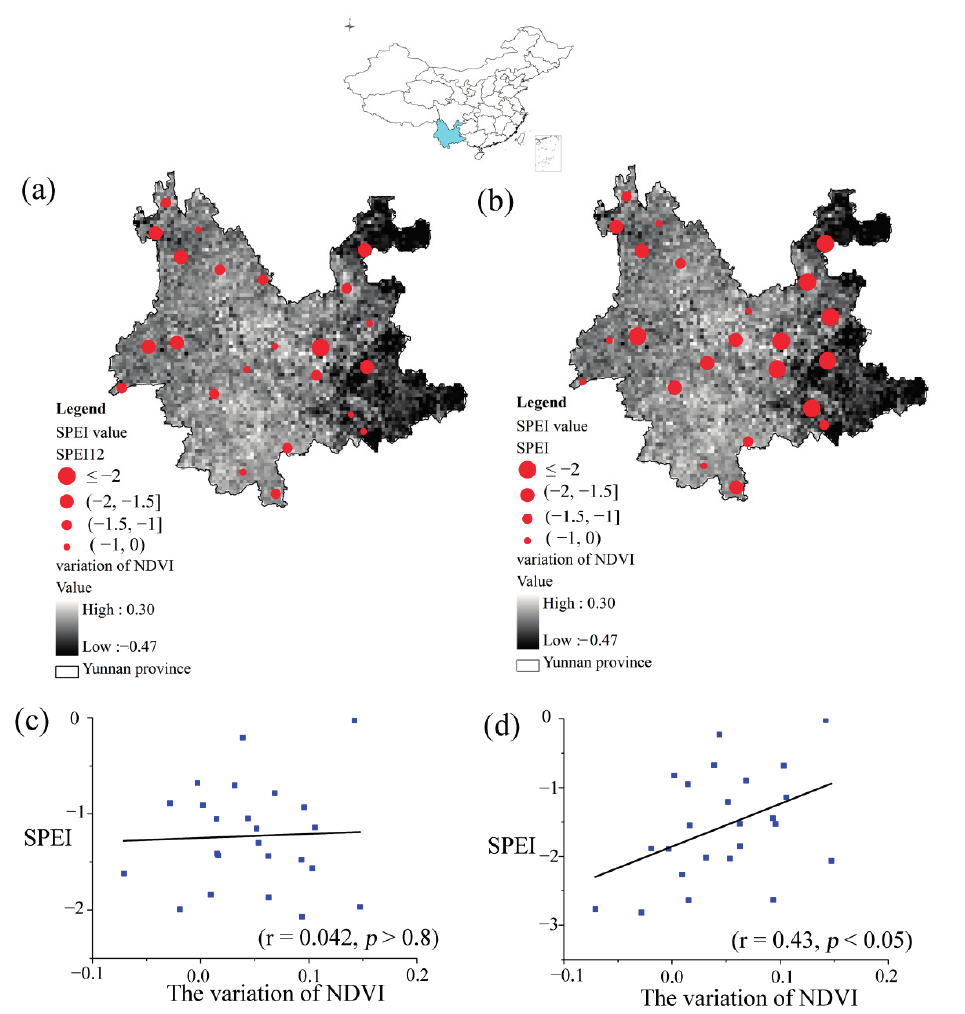
Figure 5. The extreme drought event in the Yunnan province based on the SPEI-12 ( a ) and on the SPEI opt ( b ); The base map is the variation of NDVI in October of 2009; ( c ) The scatter plot based on the SPEI-12; ( d ) The scatter plot based on the SPEI opt . It considers both the growing season (April to October) and the time when the extreme drought condition